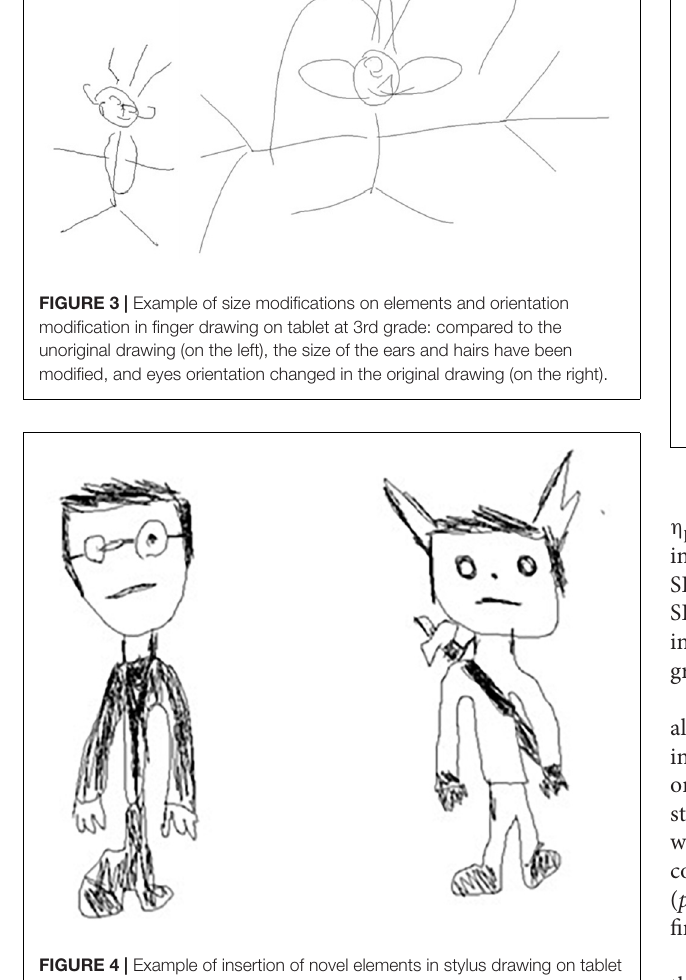
FIGURE 4 | Example of insertion of novel elements in stylus drawing on tablet at 6th grade: compared to the unoriginal drawing (on the left), ears have been added to the original drawing (on the right).